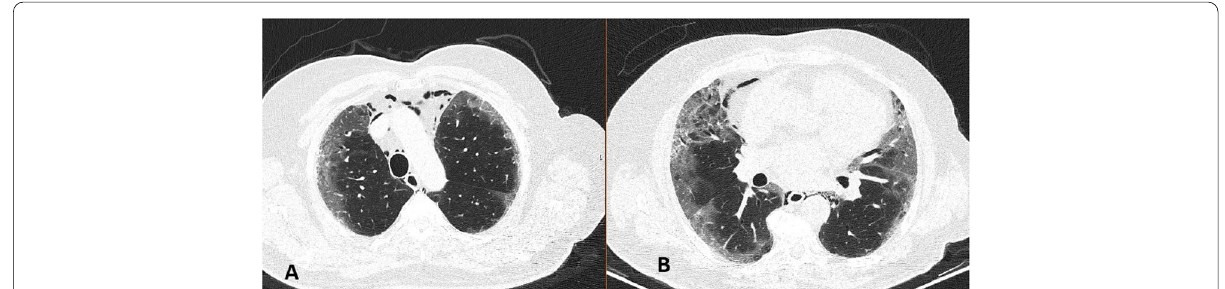
Fig. 1 Chest CT obtained at presentation to the ED in case 1, demonstrating mediastinal air ( A ). It shows bilateral ground-glass opacities and parenchymal consolidation ( A – B )